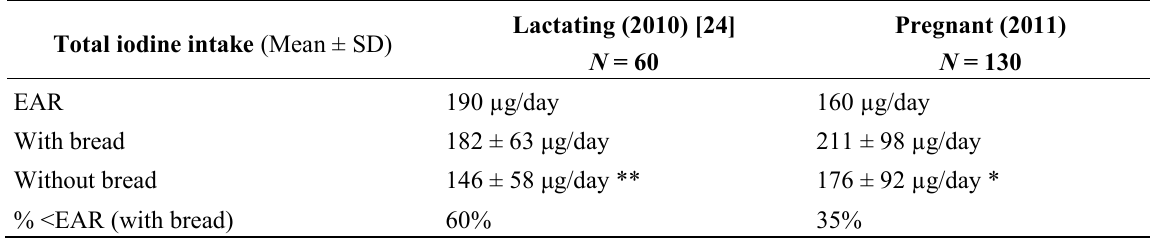
Table 4. Dietary intake of iodine post-fortification in pregnant and lactating Australian women. Lactating (2010) [24] Pregnant (2011) Total iodine intake (Mean ± SD) N = 60 N = 130 EAR 190 µg/day 160 µg/day With bread 182 ± 63 μg/day 211 ± 98 µg/day Without bread 146 ± 58 μg/day ** 176 ± 92 µg/day * % <EAR (with bread) 60%